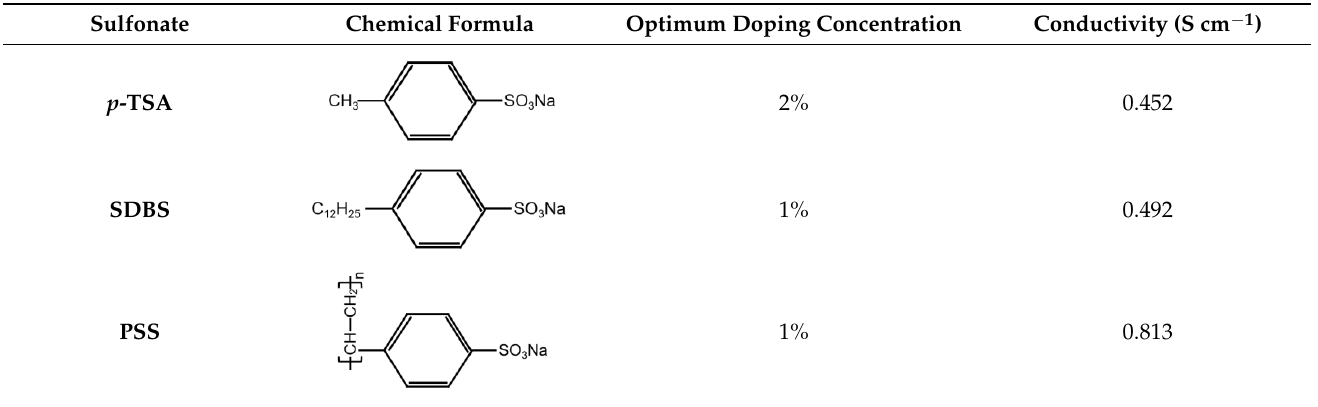
Figure 12. Effect of type and wt% of sulfonate on the surface resistance of deposited PPy/CNCs. Table 3. Effect of different sulfonates on the conductivity of PPy/CNCs.